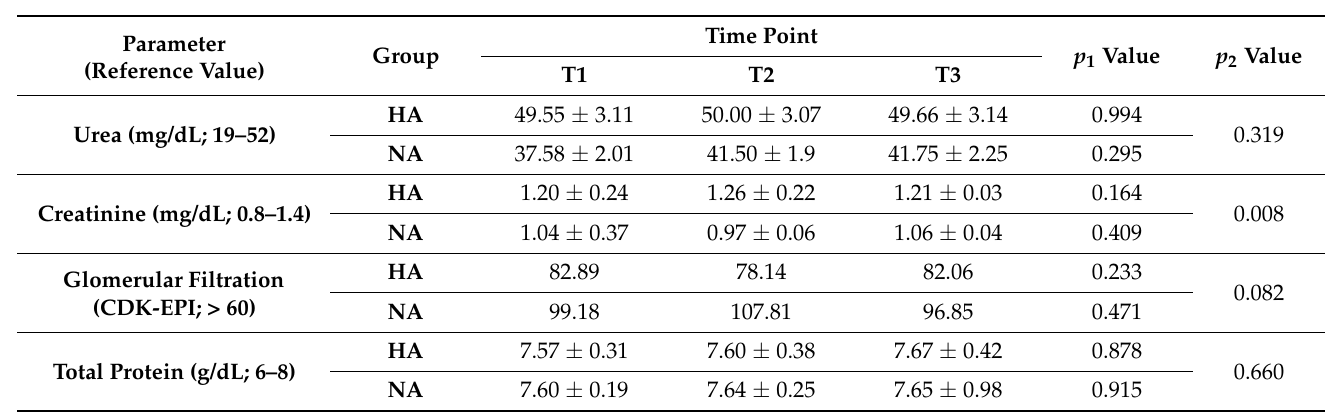
Table 7. The renal biomarkers of the athletes in the two study groups at the three time points of the study.